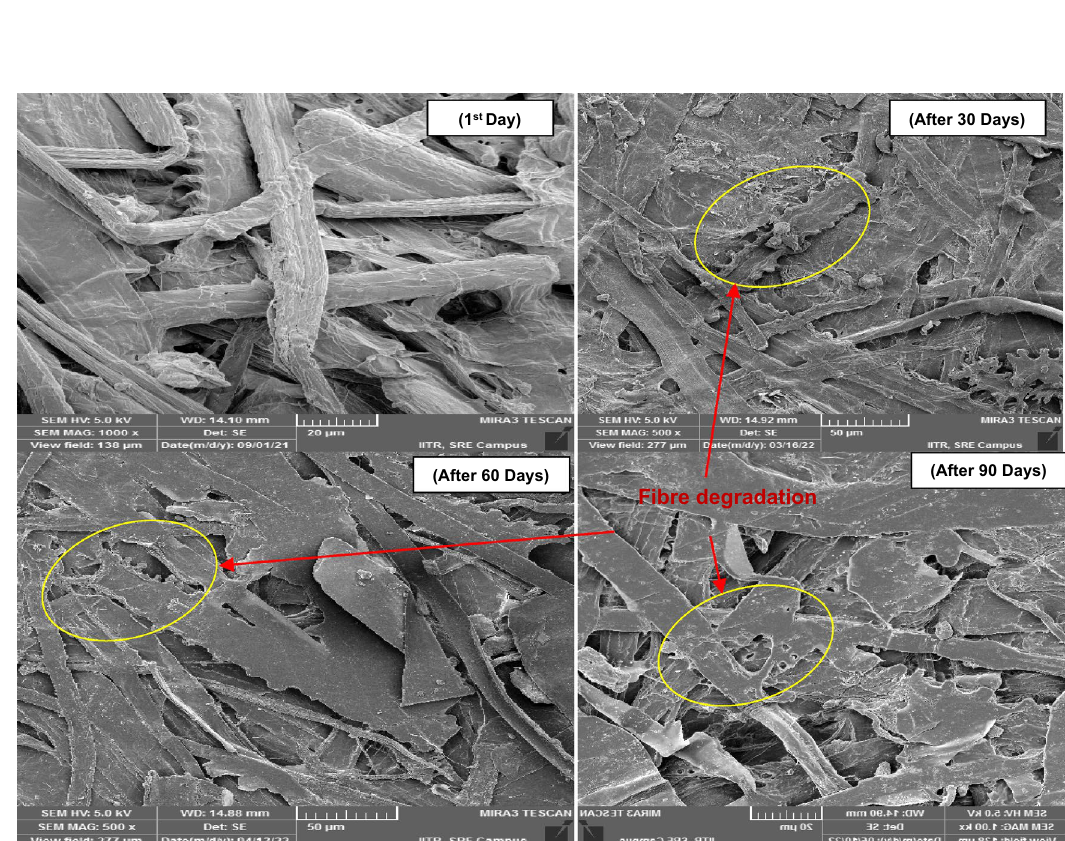
Figure 6. FE-SEM image analysis of the pulp sheet exposed to